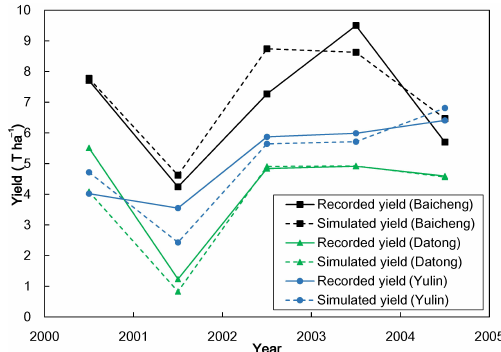
Figure 3. Calibration of the genetic parameters using the recorded yields of spring maize at Baicheng, Datong and Yulin stations.